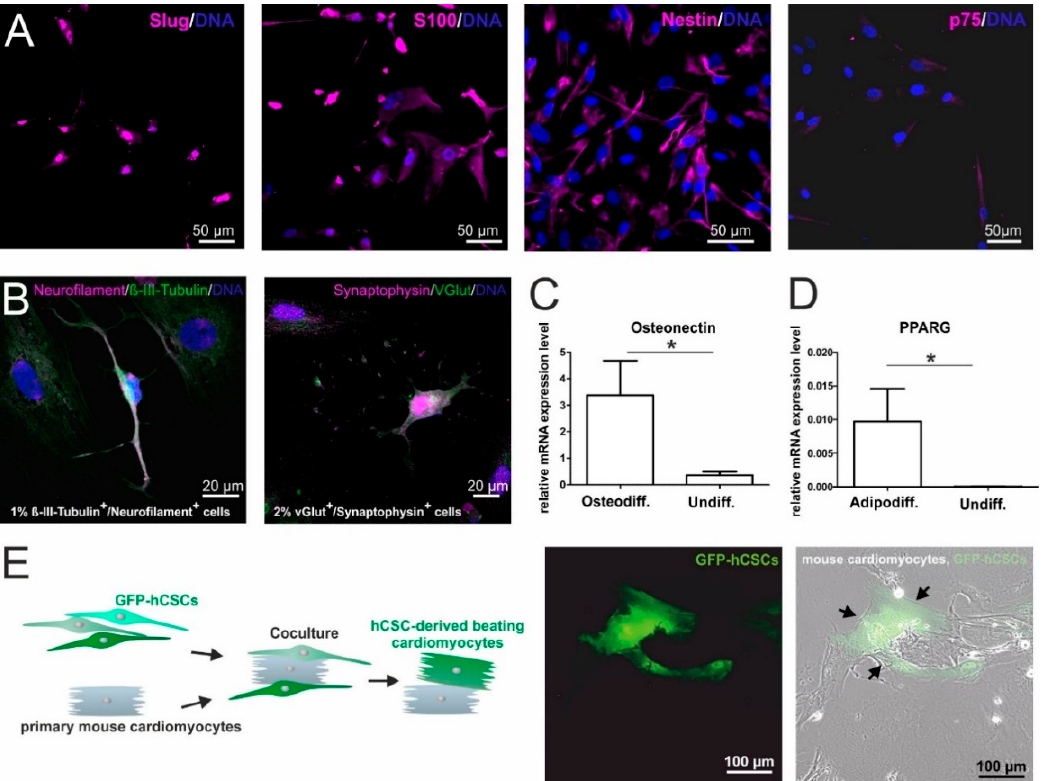
Figure 1. In vitro characterization of human cardiac stem cells (hCSCs): ( A ) Immunocytochemical stainings of cultured hCSCs showed the expression of the NCSC markers Slug, S100, Nestin and p75. ( B ) Directed differentiation of hCSCs generated Neurofilament + / β -II-Tubulin + and Synaptophysin + /VGlut + neuron-like cells. ( C ) Application of an osteogenic differentiation medium resulted in the upregulation of Osteonectin mRNA (Mann Whitney Test, * p < 0.05). ( D ) Application of an adipogenic differentiation protocol resulted in the upregulation of PPARG mRNA (Mann Whitney Test, * p < 0.05). ( E ) GFP + hCSCs differentiate into beating cardiomyocytes (arrowheads) upon coculture with primary mouse cardiomyocytes.